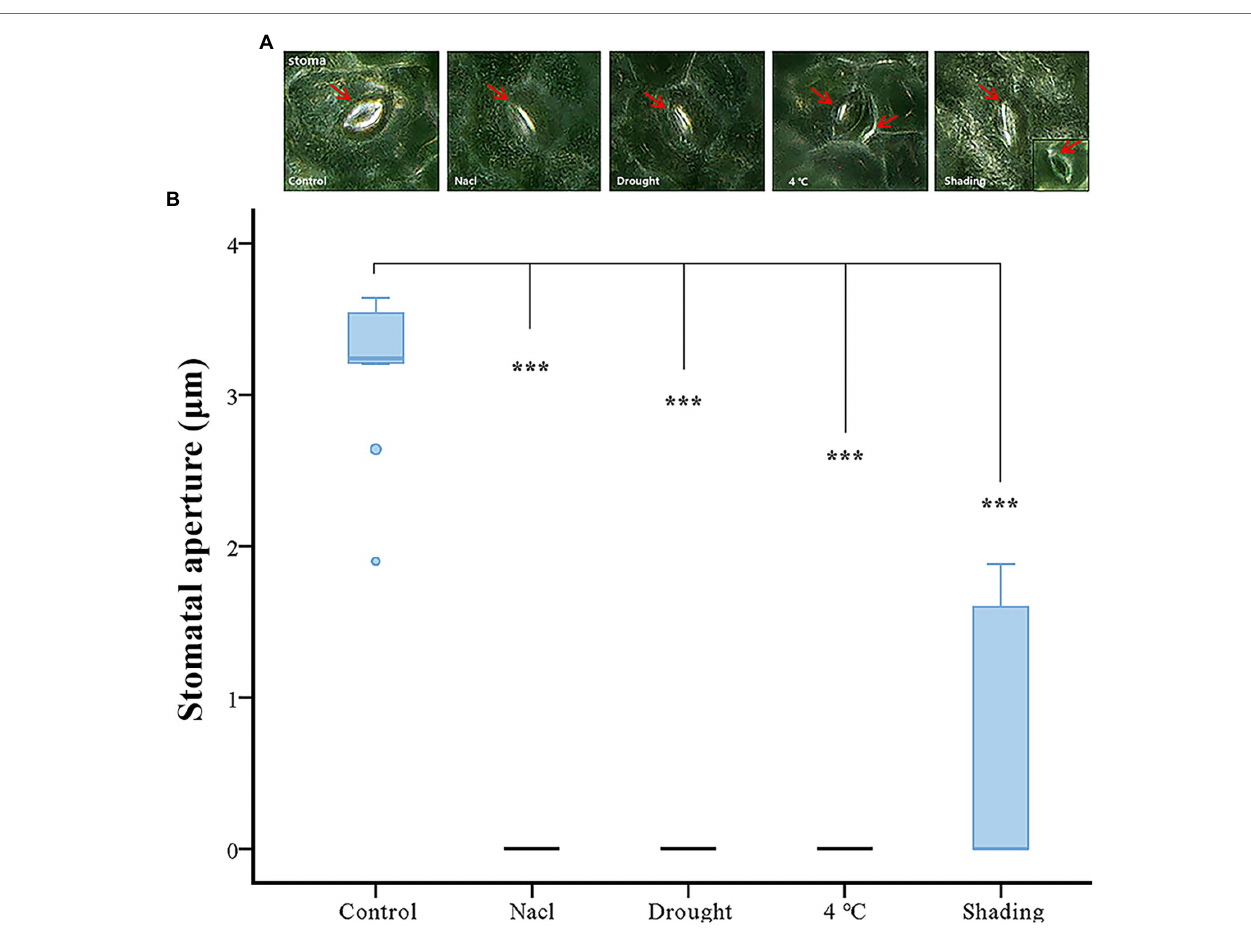
FIGURE 7 | Effect of abiotic stress on stomatal aperture. (A) The microscope of stomatal movement of vegetable soybean leaves under control and abiotic stress. The red arrow indicates the position of the stoma. (B) Inhibition of stomatal aperture by abiotic stress. *** p ≤